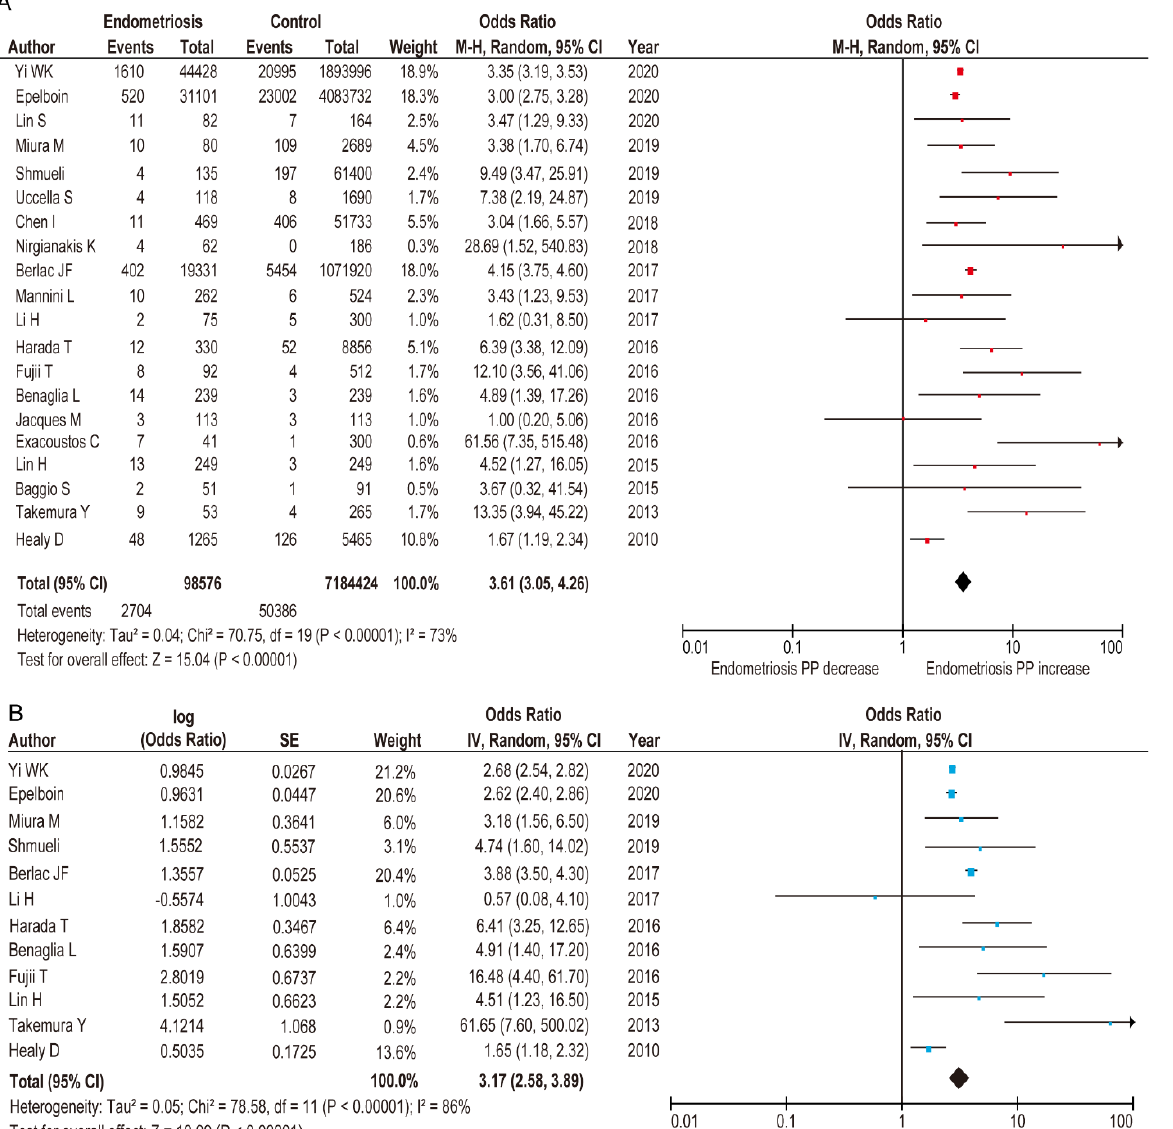
Figure 3. Meta-analysis of the influence of endometriosis on the occurrence of PP. Reproduced and updated, Matsuzaki S et al. [24] The association of endometriosis with placenta previa and postpartum hemorrhage: a systematic review and meta-analysis/Figure 2. Meta-analysis of the effect of endometriosis on the rate of placenta previa. Copyright (2021), with permission from Elsevier. The position of the box is a point estimate of the OR. The size of the box represents the weight of study. A horizontal line representing the 95%CI of the study result, with each end of the line representing the boundaries of the CI. Clip CIs to arrows when they exceed specified limits. The diamond represents the combined results of the studies. The pooled OR of the ( A ) unadjusted analysis for PP and ( B ) adjusted analysis for PP between women with endometriosis and women without endometriosis is shown. The forest plots were ordered within the stratum by year of publication and relative weight (%) of the study. Substantial heterogeneity was observed in A ( I 2 = 73%), and considerable heterogeneity was observed in B ( I 2 = 86%). Some values slightly vary from the original values, as calculations were performed using Revman ver. 5.4.1. Abbreviations: OR, odds ratio; SE, standard error; CI, confidence interval; PP, placenta previa.